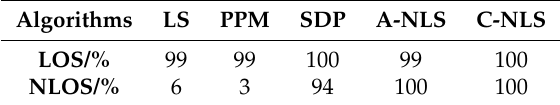
Figure 4. Convergence for algorithms in the different scenarios and environments. Above, Graphs ( a , b ) are the results in the noncooperative scenario, where (a) represents the LOS environment, while (b) represents the NLOS environment. Graphs ( c , d ) are the results in the cooperative scenario, which represent the LOS and NLOS environments, respectively. The red boxes in the figure represent the anchors, while the blue stars represent the targets. We drew the ranging link as the green dotted line and the convergence radius as the blue dotted circle. The solid points represent the results of positioning. Table 4. Convergence probability in the noncooperative scenario. PPM, parallel projection method; null space algorithm.